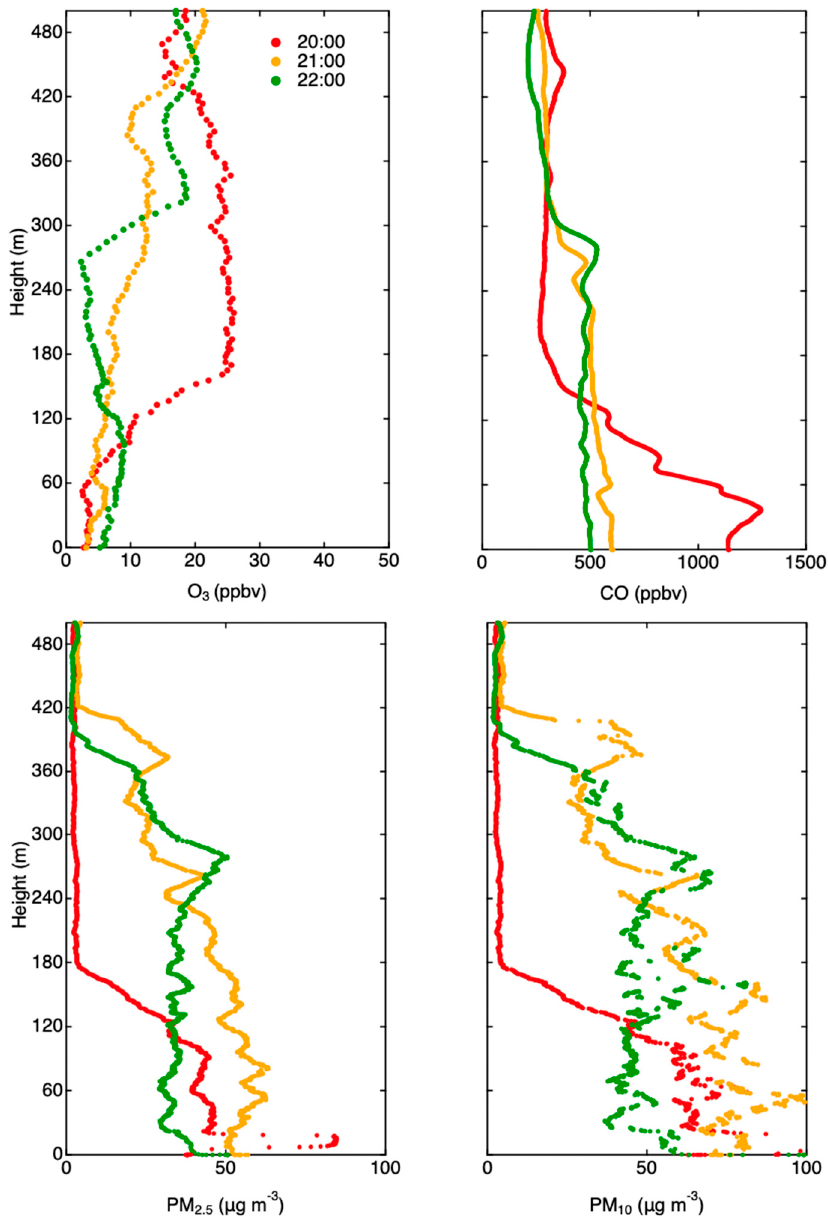
Figure 5. Evolution of vertical profiles of the concentrations of ozone, carbon monoxide, PM 2.5 , and PM 10 from land surface to an altitude of 500 m on 27 September 2018 from 20:00 to 22:00 (LT).